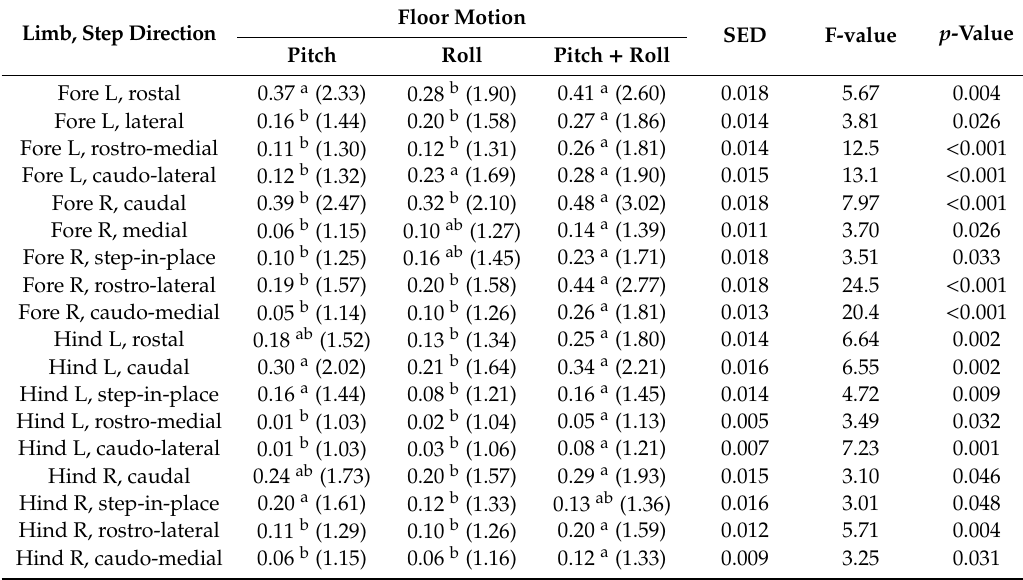
Table A3. E ff ects of type of floor motion (roll, pitch or the two combined) on stepping behavior of the four limbs of sheep ( n = 6). Data presented as (log 10 + 1) steps / 20 min, with back-transformed means provided in brackets. Comparisons with significantly di ff erent counts of stepping responses are presented. Di ff erent superscript letters denote significant di ff erences. These data are also presented graphically in Figure 3 (L = left and R =